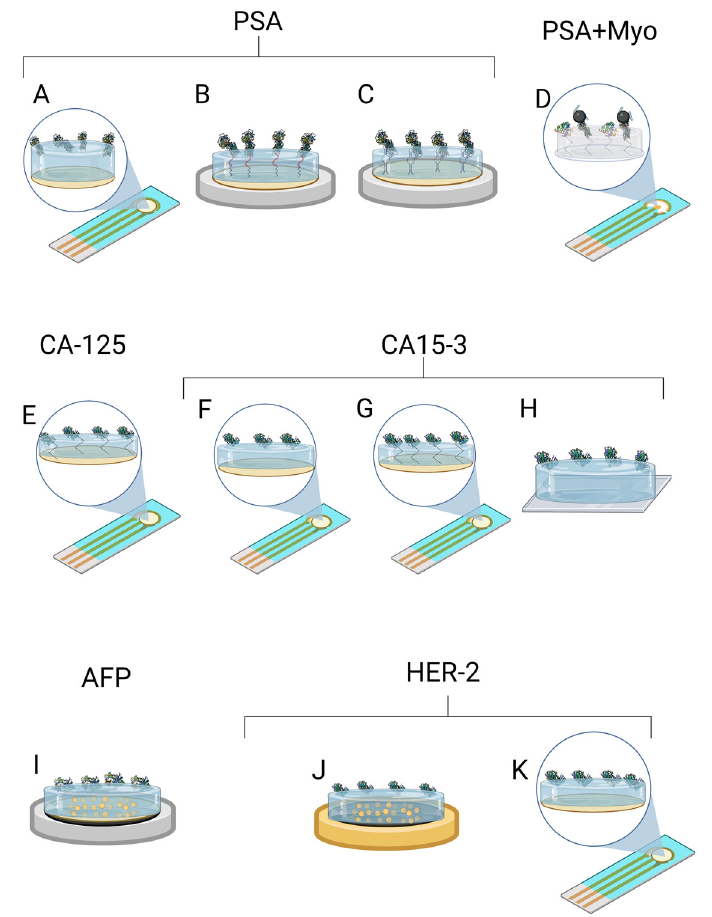
Figure 2. MIP application for detection of cancer biomarkers. All drawings were designed using Biorender.com based on the reviewed articles. ( A ) The Ppy-based MIP with PSA imprints on a gold screen-printed electrode. ( B ) A gold electrode with glutaraldehyde–cysteamine matrix pretreatment coated with polytoluidine blue for analyte PSA entrapment. ( C ) Thiolated aptamer–PSA complex was immobilised on the gold electrode coated with polydopamine for analyte PSA entrapment. ( D ) A screen-printed electrode with self-assembled dithiodipropionic acid di(N-hydroxysuccinimide ester) with immobilised analytes, PSA, and Myo coated with polymethyl acrylate for imprinting. To detect PSA, MIP was exposed to Fe 3 O 4 nanoparticles decorated with multi-walled carbon nanotubes, graphene oxide, and specific antibodies for PSA. ( E ) A gold screen-printed electrode with self-assembled cysteamine coated with Ppy for analyte CA-125 entrapment. ( F ) A gold screen-printed electrode coated with poly(2-aminophenol) for analyte CA15-3 entrapment. ( G ) The MIP based on the toluidine blue (TB) film was polymerised via glutaraldehyde on self-assembled 8-amino-1-octane thiol-modified AuSPE for analyte CA15-3 entrapment. ( H ) A fluorine-doped tin oxide-glass electrode coated with Ppy for analyte CA15-3 entrapment. ( I ) A glassy carbon electrode with polythionine and gold nanoparticles coated with polydopamine for analyte AFP entrapment. ( J ) Laser-scribed graphene electrode with gold nanoparticles coated with PEDOT for analyte HER-2 entrapment. ( K ) A gold screen-printed electrode coated with polyphenol for analyte HER-2 entrapment. All drawings were designed using Biorender.com, accessed on 26 December 2022.